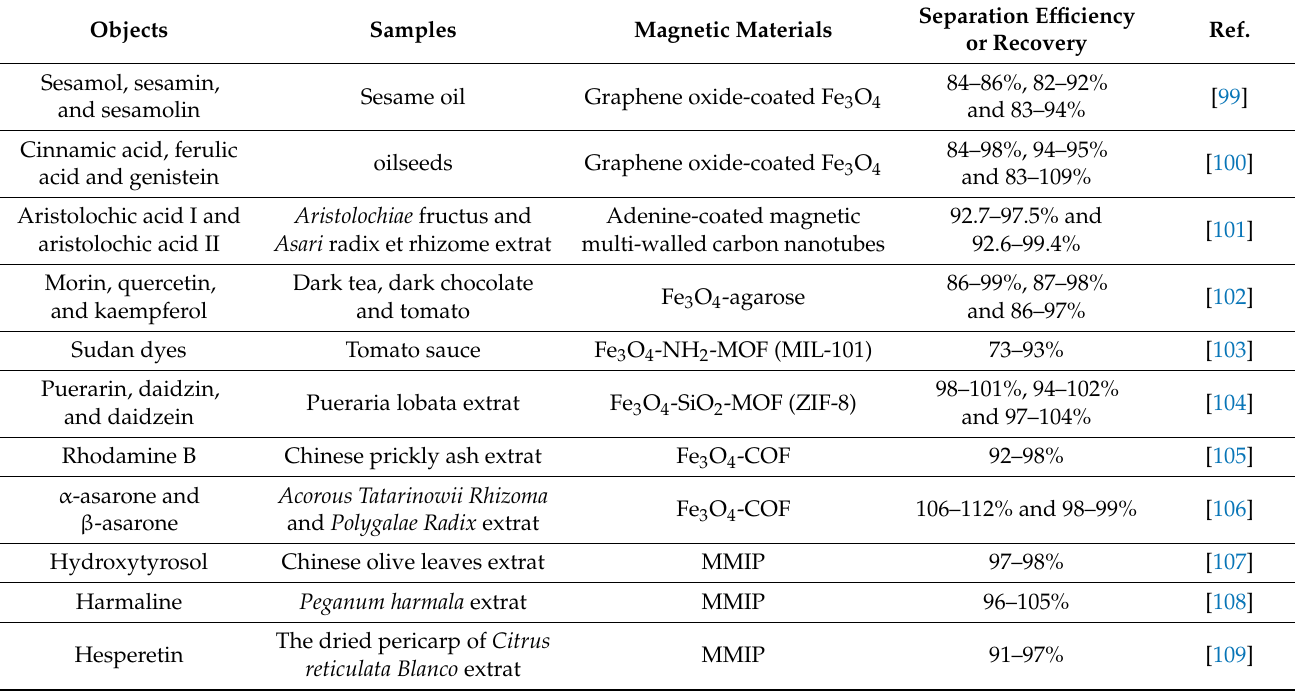
Table 3. The application of magnetic solid-phase extraction in the separation of bioactive